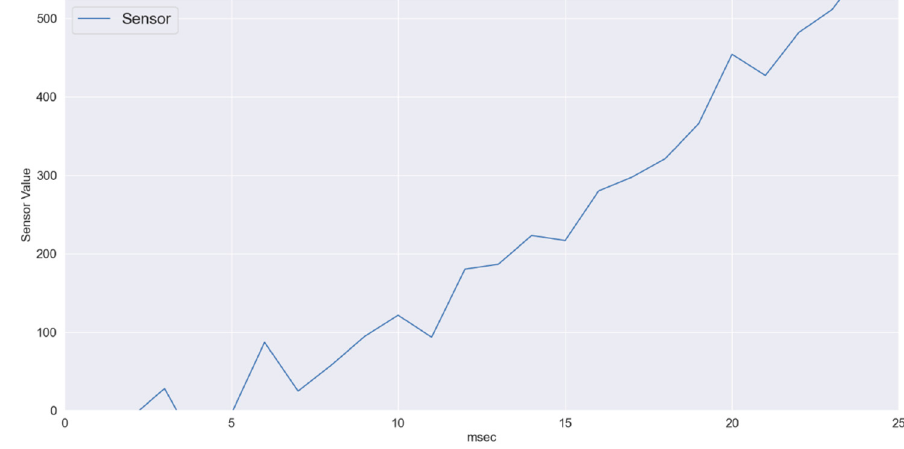
Figure 6. XGB regressor-average data variations: Predicted vs. Actual.